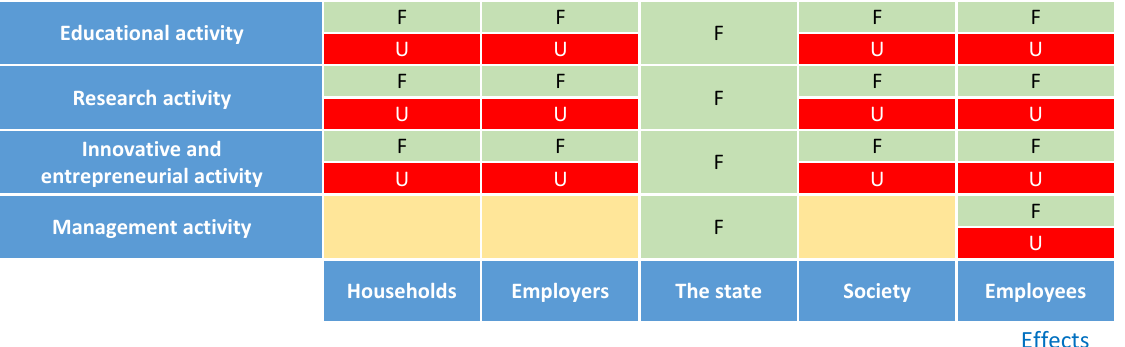
Figure 2. The matrix of necessary changes (source – state)